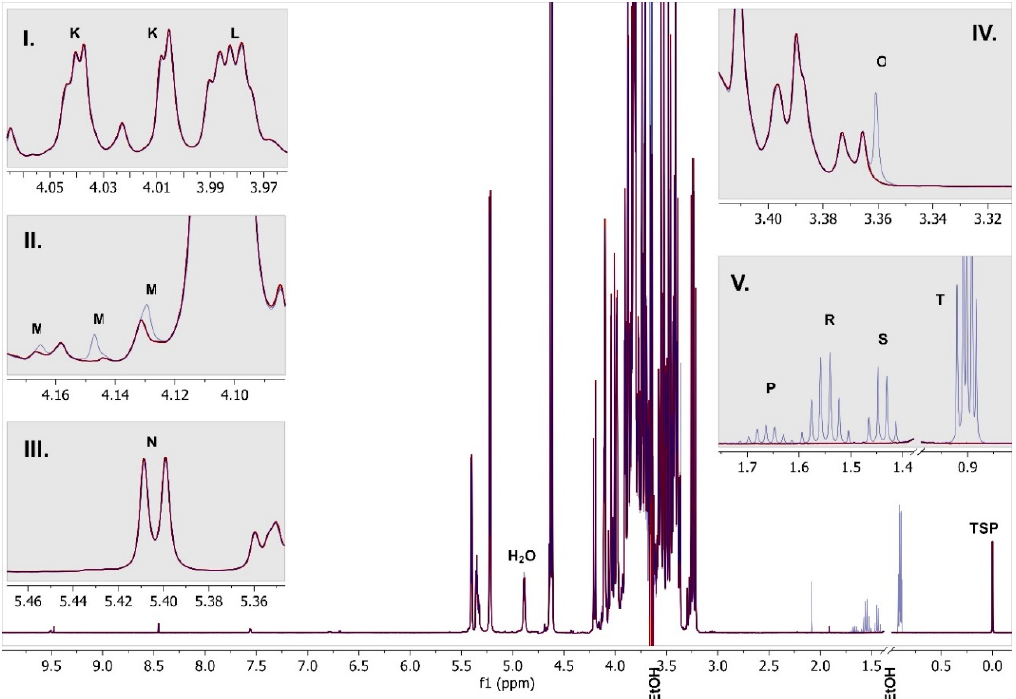
Figure 5. One-dimensional 1 H NMR spectrum of herbal liqueur overlayed with spiked sample (blue). I .– V .: enlargements. The labelled signals are: K: fructose (dd), L: fructose (“pe”), M: ethyl acetate (q), N: sucrose (d), O: methanol, P: isopentanol (no), R: 1-propanol (hx), S: isopentanol (q), T: overlayed triplet of 1-propanol and doublet of isopentanol, H 2 O: water (suppressed), TSP: trimethylsilyl propionate-d4; EtOH: ethanol (suppressed, cut out).